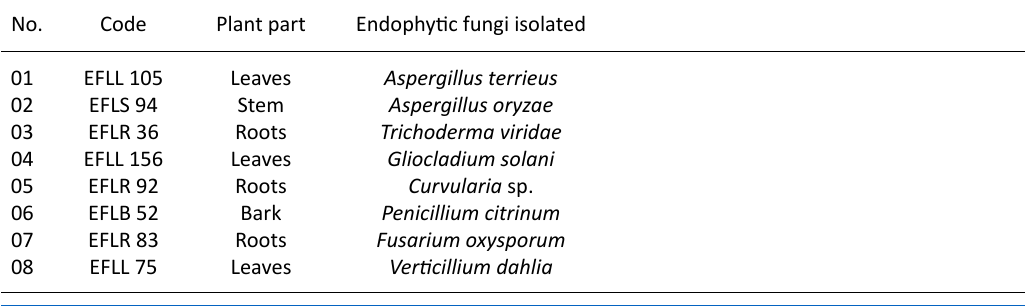
Table 2. Part wise isolation of endophytic fungi from the host plant